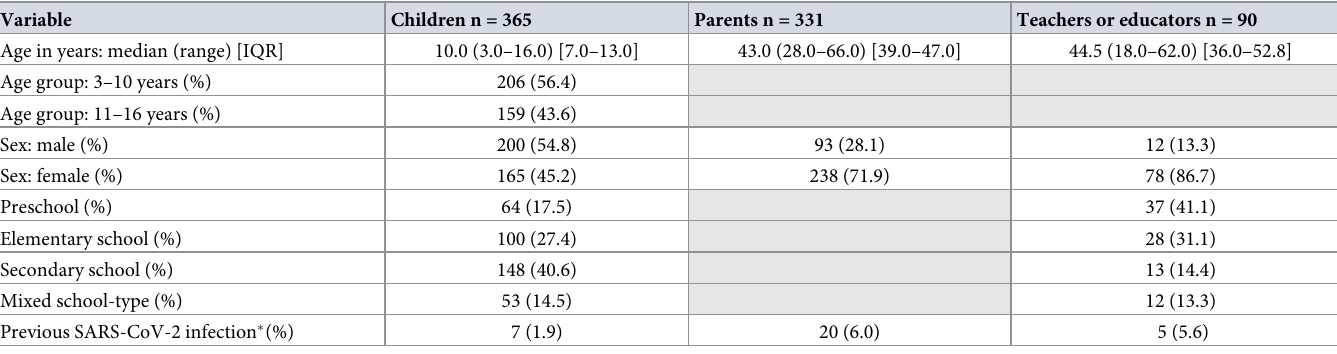
Table 1. Descriptive statistics at baseline of the Augsburg Plus Cohort.